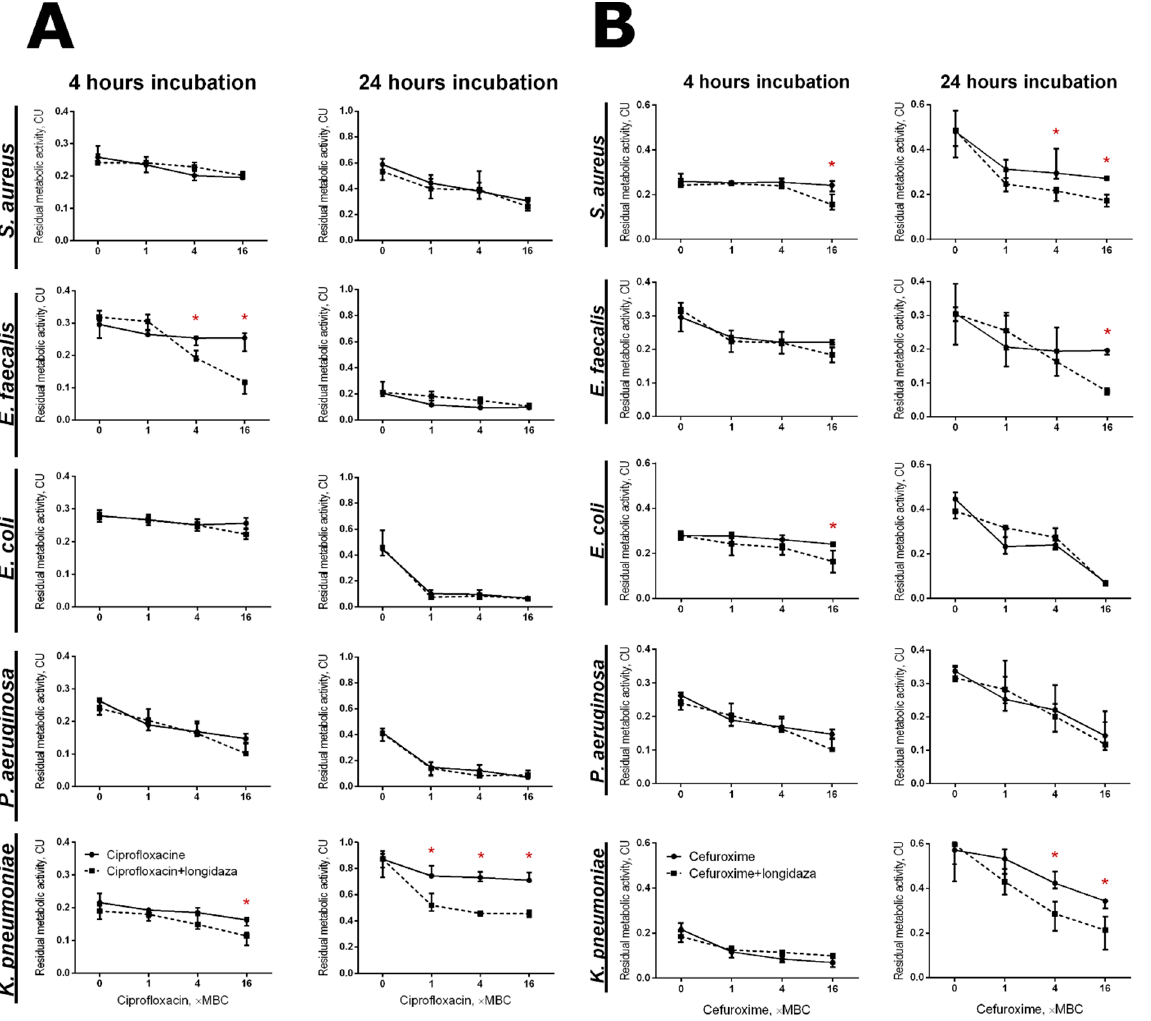
Figure 7. The effect of Longidaza ® on the susceptibility of biofilm-embedded bacteria to antimicrobials. Longidaza ® was added to 48-h-old biofilms to a final concentration of 750 IU/mL. Ciprofloxacin ( A ) and cefuroxime ( B ) were added up to final concentrations of 1–16 × MBC (see Table S1 for the values). After 24 h incubation, the biofilms were washed twice with sterile 0.9% NaCl. The viability of the adherent cells was analyzed with an MTT assay. The asterisks (*) denote a statistically significant difference of the residual respiratory activity in the untreated wells (solely antimicrobials) and wells with the combined treatment ( p < 0.05).